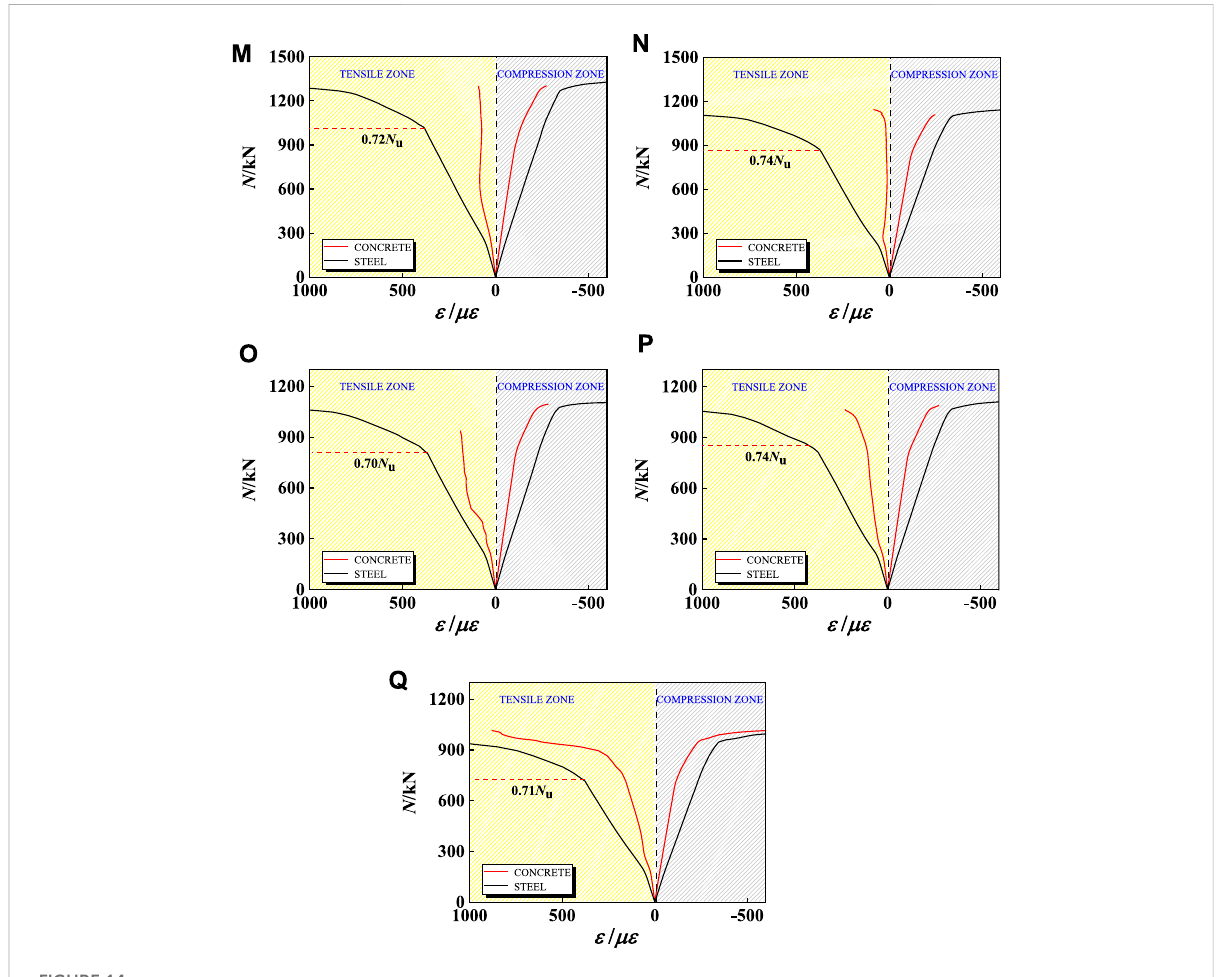
FIGURE 14 Load-strain curves of concrete and steel tube (A) SHC1 (B) SHC2 (C) SHC3 (D) SHC4 (E) SHC5 (F) SHC6 (G) SHC7 (H) SHC8 (I) SHC9 (J) SHC10 (K) SHC11 (L) SHC13 (M) SHC14 (N) SHC16 (O) SHC18 (P) SHC19 (Q) SHC23.